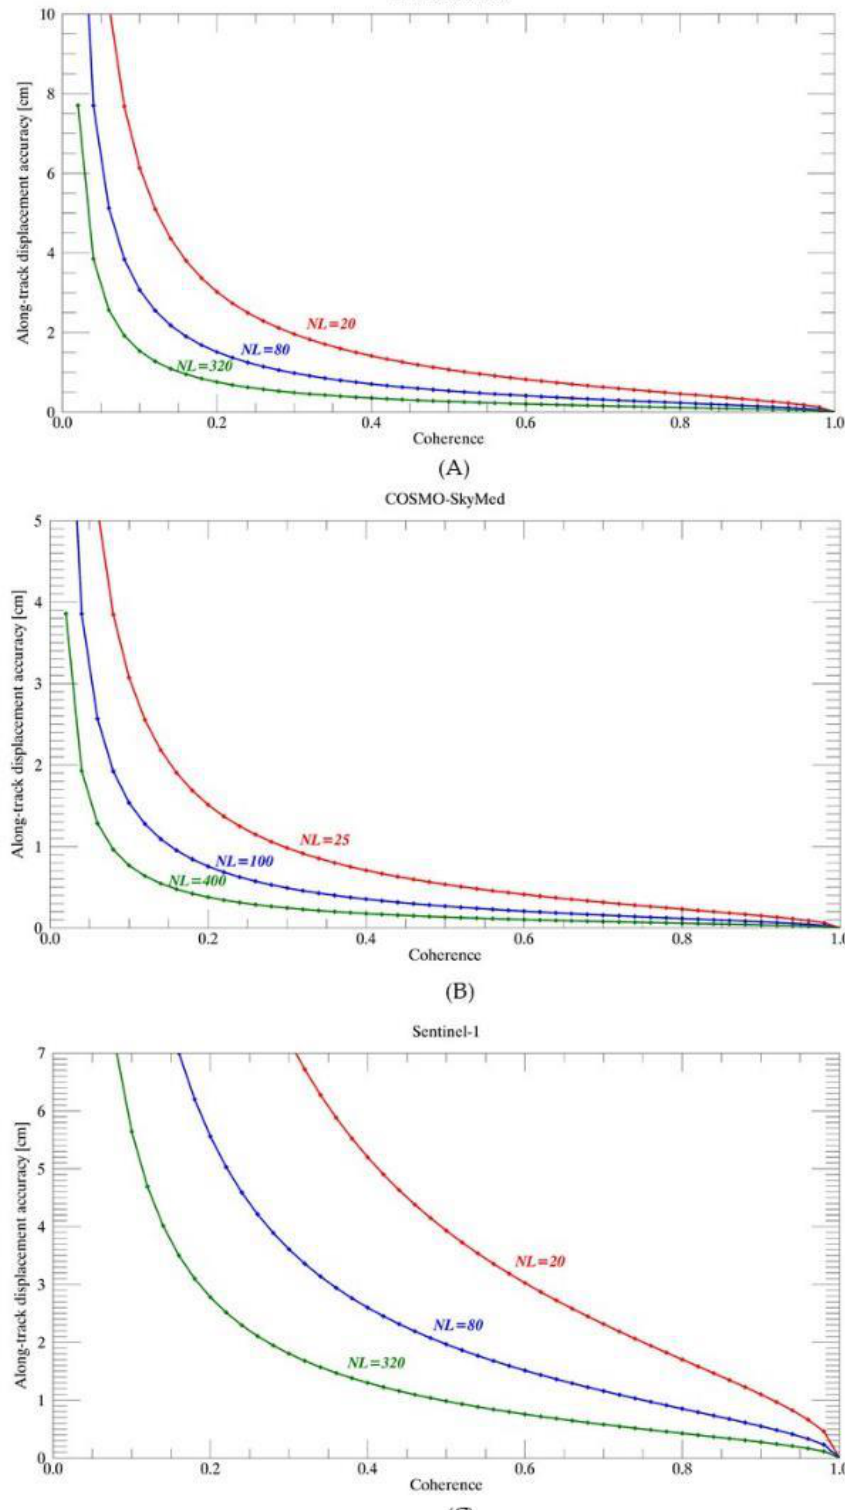
Figure 14. Plot of the along-track displacement accuracies vs coherence for the Envisat / ASAR ( A ), COSMO-SkyMed ( B ) and Sentinel-1 ( C ) case using the MAI technique for di ff erent NLs (e ff ective look numbers).